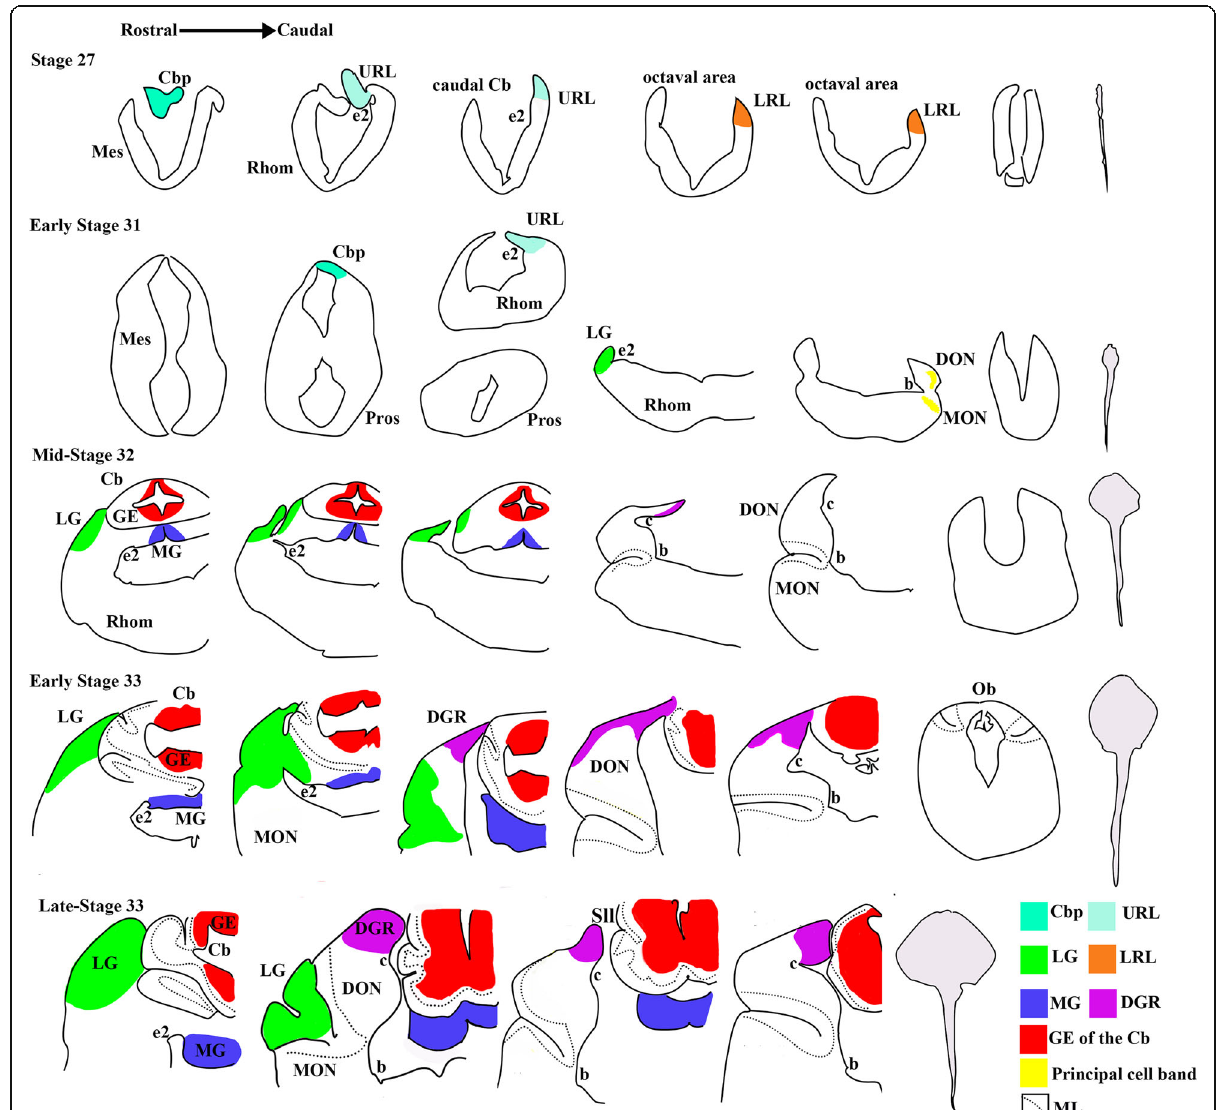
Fig. 3 Leucoraja erinacea, anatomical drawing of the brain of at several developmental stages. Representative sections are described in a rostral to caudal manner. Brain regions are color coded (see legend). Outlines of whole specimen morphology is drawn to scale in grey. Brain regions are not drawn to scale. Abbreviations: b, sulcus b; c, sulcus c; Cb, cerebellum; Cbp , cerebellar plate; DGR , dorsal granular ridge; DON , dorsal nucleus; e2, sulcus e2; GE , granular eminences; LG , lateral granule mass; LRL , lower rhombic lip; MG , medial granule cell mass; ML , molecular layer; MON , medial nucleus; Ob , obex; Sll , sulcus longitudinalis lateralis; URL , upper rhombic